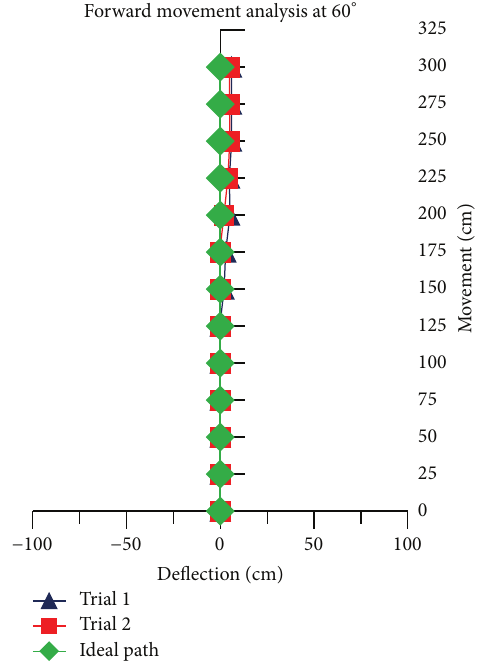
Figure 12: Forward movement versus deflections at 𝜃 = 45 ∘ .